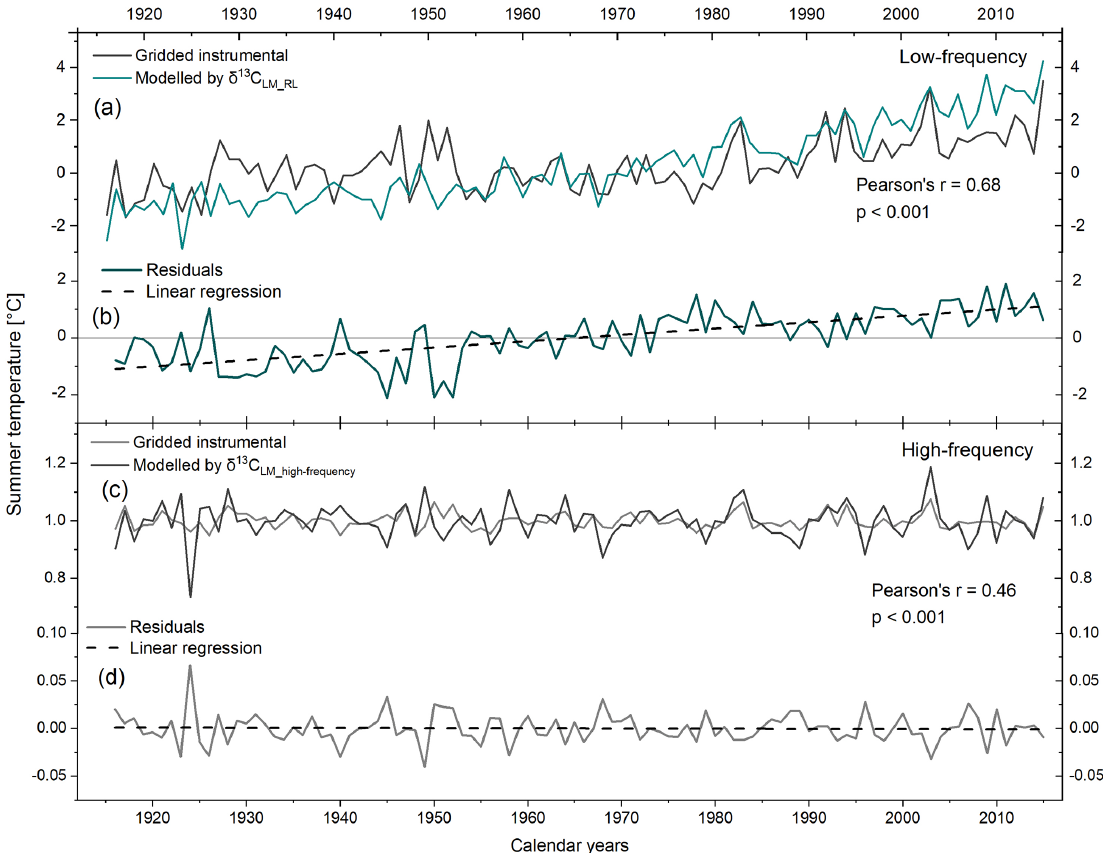
Figure 6. Gridded instrumental and modelled JJA temperatures by (a) δ 13 C LM_RL values and (c) δ 13 C LM_high-frequency indices from 1916– 2015. (b, d) Plots of residual trends through time for low- and high-frequency.